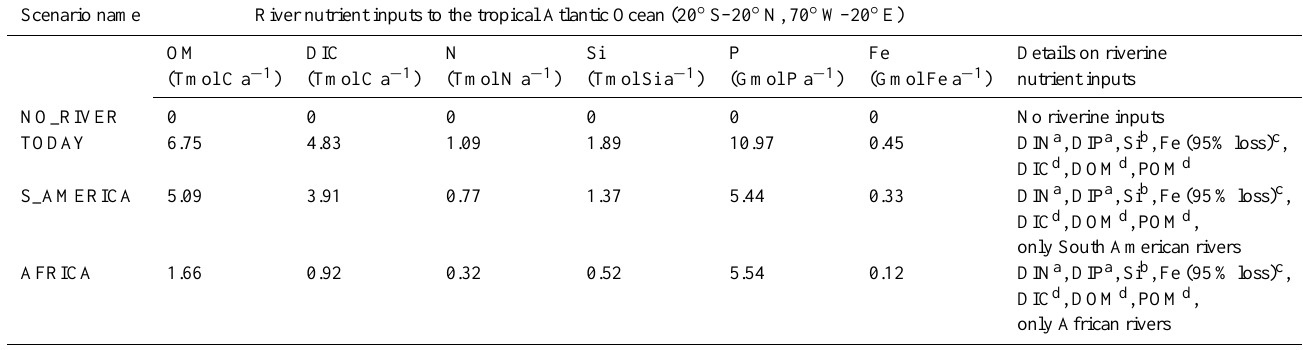
Table 1. River nutrient scenarios.